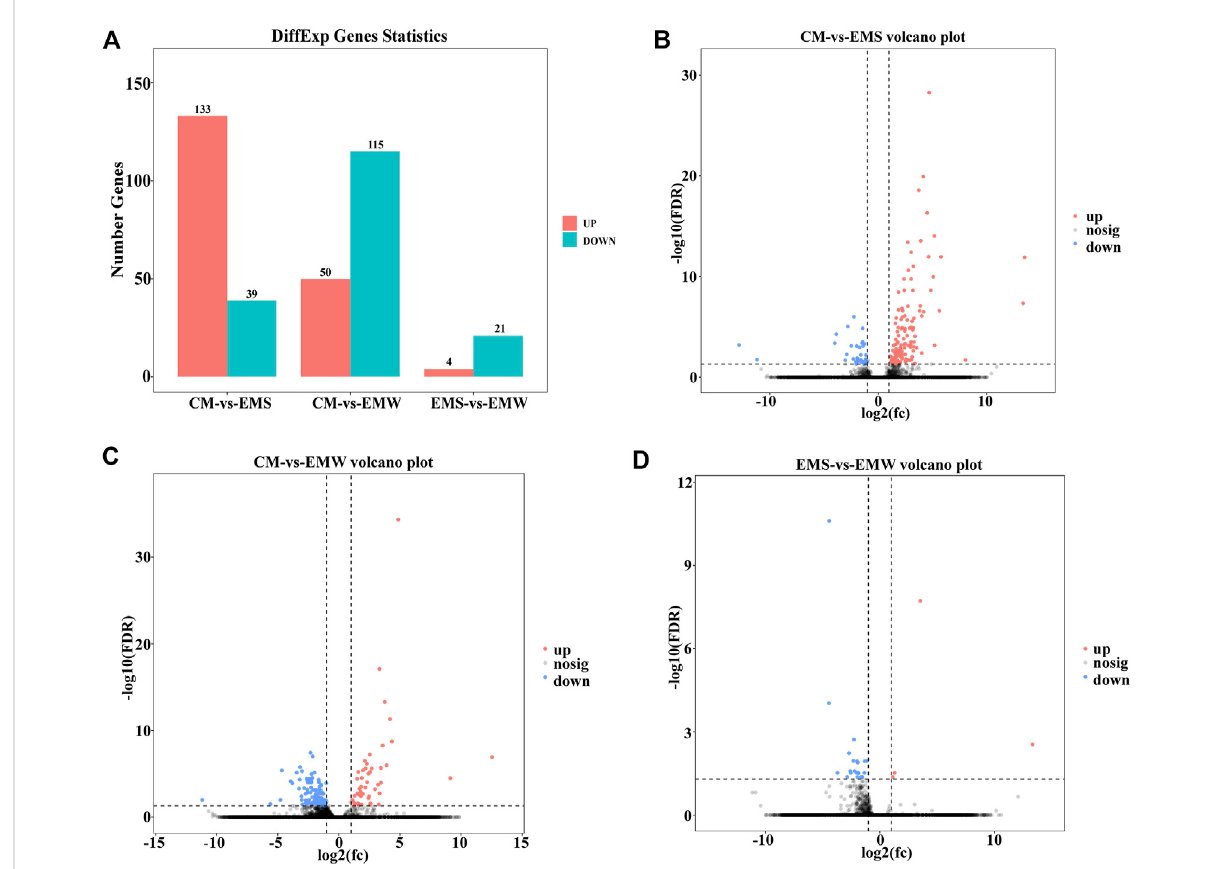
FIGURE 1 Differences in gene number in CM vs. EMS, CM vs. EMW, and EMS vs. EMW groups. (A) The bar chart shows the number of genes in the CM vs. EMS,CMvs.EMW,andEMSvs.EMWgroups. (B) VolcanoplotofDEGsinCMvs.EMS. (C) VolcanoplotofDEGsinCMvs.EMW. (D) VolcanoplotofEMS vs.